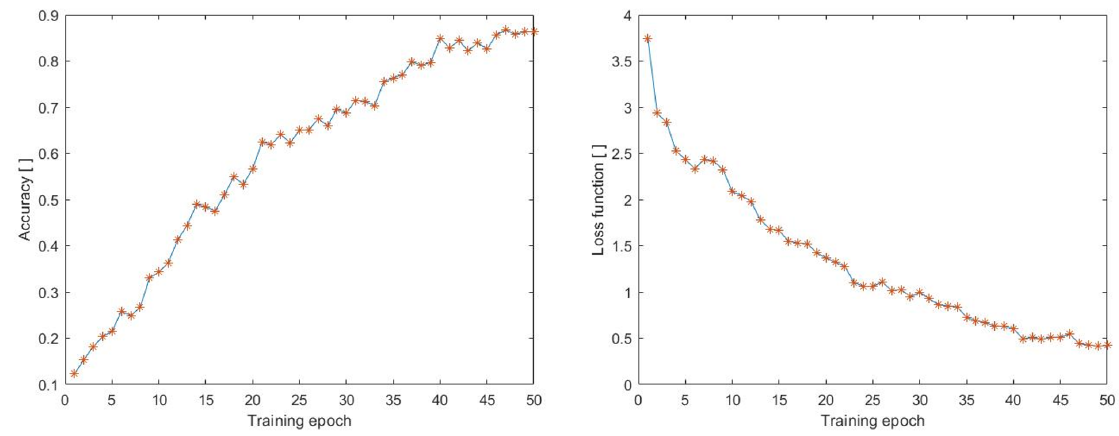
Figure 11. Accuracy during training process on the dataset (MOD20).